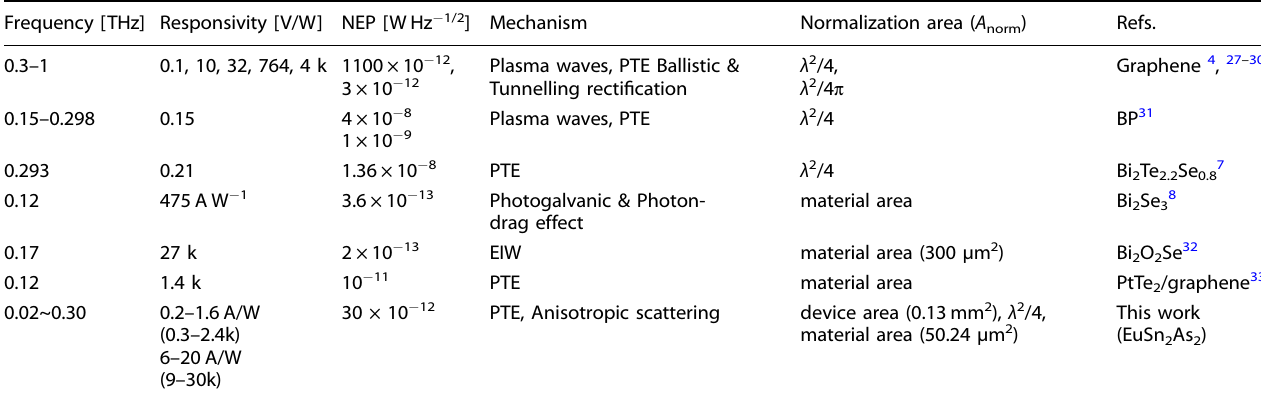
Table 1. Comparison of the latest reported emerging THz